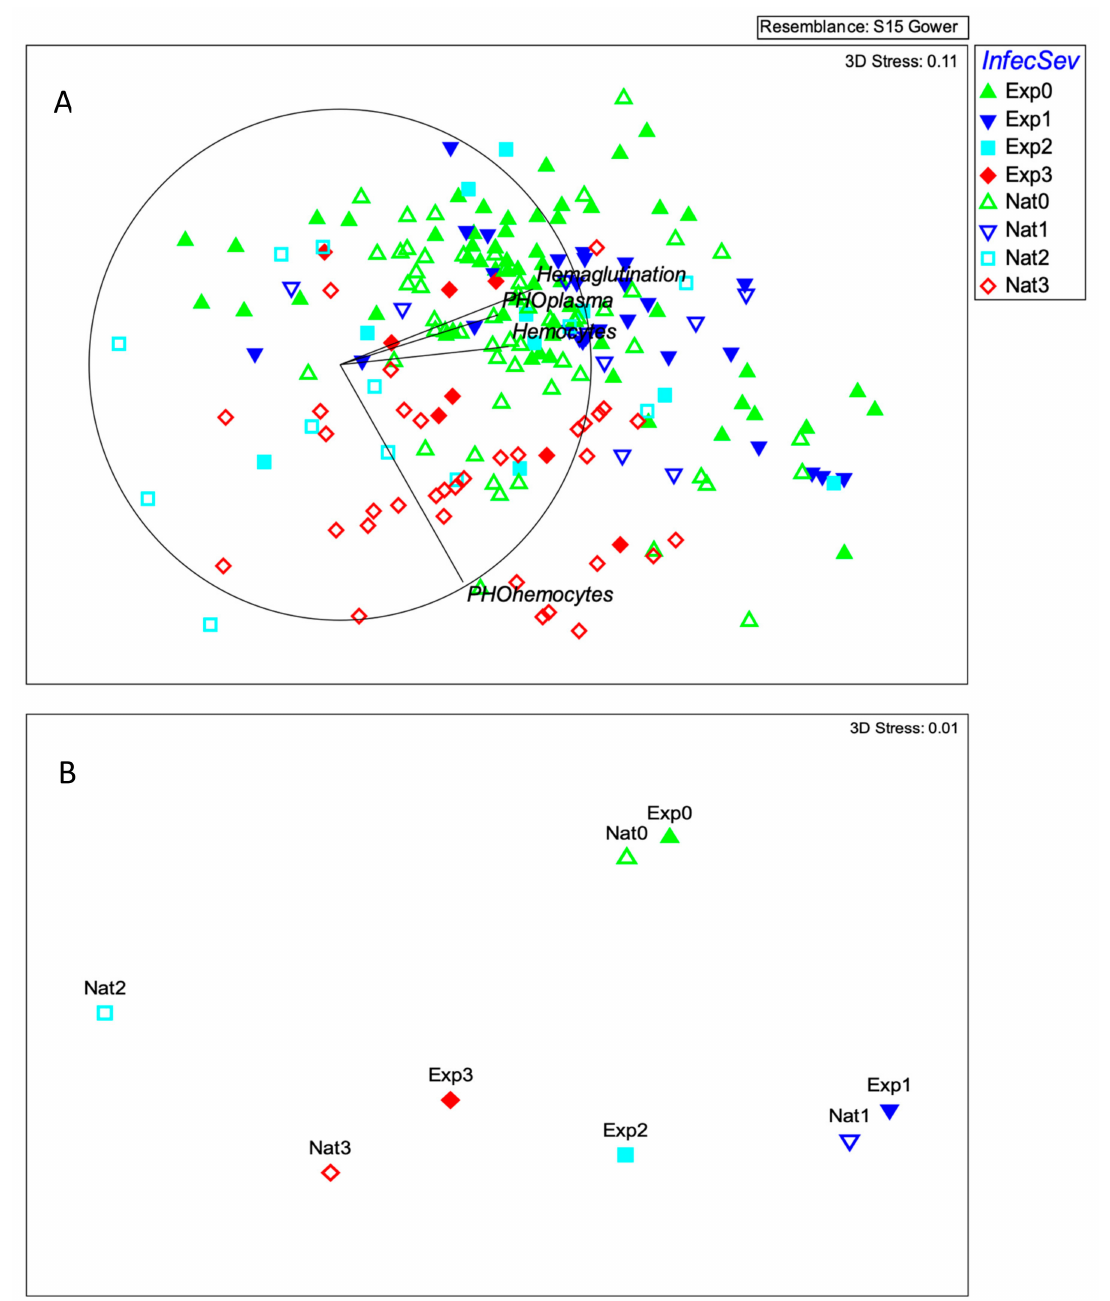
Figure 1. Non-metric multidimensional scaling (NMDS) of immunological response of P. argus to infection by PaV1; PO: total phenoloxidase activity in plasma and hemocytes (optical density, 490 nm), hemocytes concentration (cells mm − 3 ), and hemagglutination (titer). The colors correspond to the severity of the infection (0: uninfected; 1: lightly; 2: moderately; and 3: severely infected, which was determined on the basis of PCR and histological criteria). Full symbols correspond to experimental challenge and empty to natural infection process; 112 organisms ( A ), and centroids of severity and origin of infection ( B